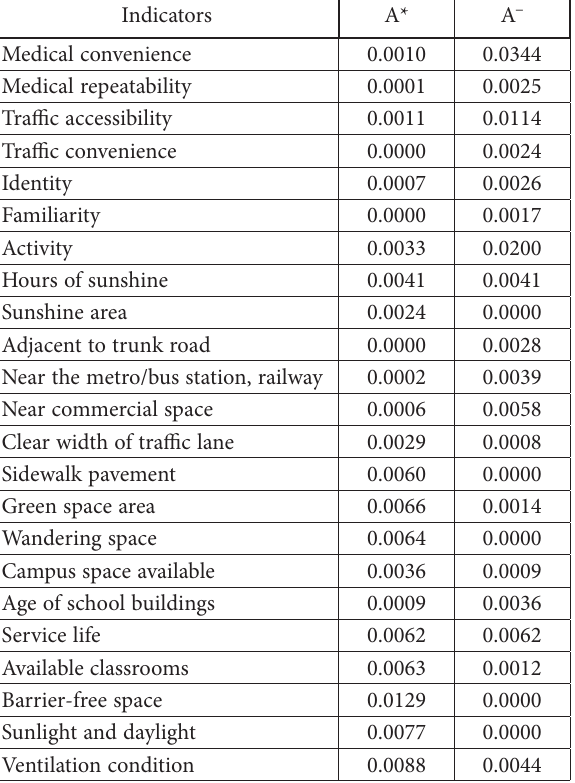
Table 8. Positive and negative ideal solutions